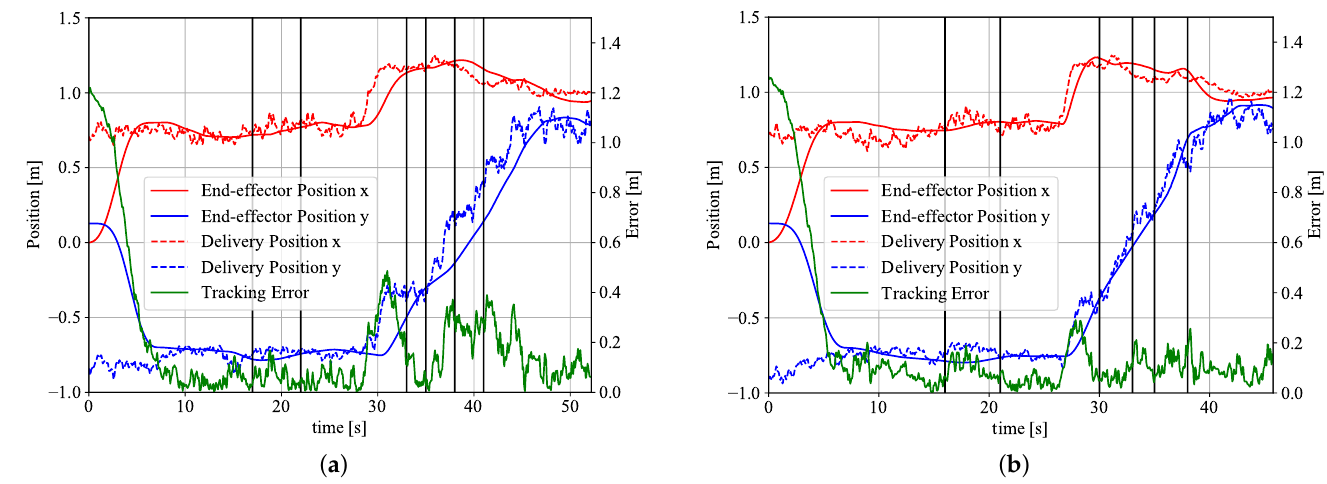
Figure 7. Tracking performance. ( a ) When motion prediction is not used; ( b ) When motion prediction is used.